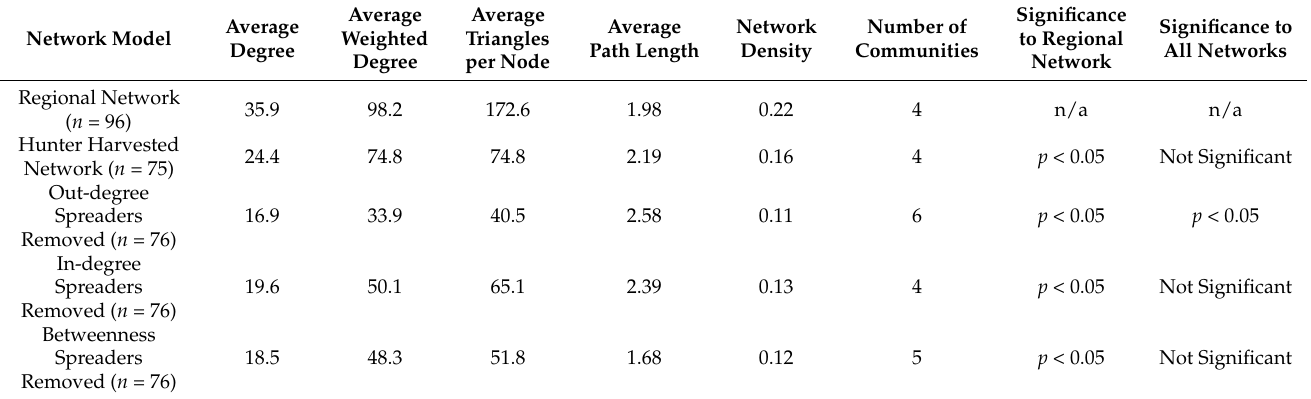
Figure 7. Impact of Hunter Harvest and Super-Spreader Management on Social Networks. Shown is ( A ) the Regional Network, ( B ) the Regional Network post-hunter harvest, ( C ) the Regional Network minus the top 20 out-degree potential super-spreaders, ( D ) the Regional Network minus the top 20 in-degree potential super-spreaders, and ( E ) the Regional Network minus the top 20 betweenness potential super-spreaders. Table 3. Impact of Hunter Harvest and Disease Management on Network Statistics. The table shows the changes in the Regional Network statistics before and post-hunter harvest, and after removal of the top 20 out-degree, in-degree, and betweenness super-spreaders. Changes in Avg degree, Avg weighted degree, Avg triangles per node, Avg path length, network density, and number of communities were compared before and post-hunter harvest, and after removal of out-degree, in-degree, and betweenness super-spreaders. Statistical analysis was performed using a one-way ANOVA test, where p < 0.05 was considered